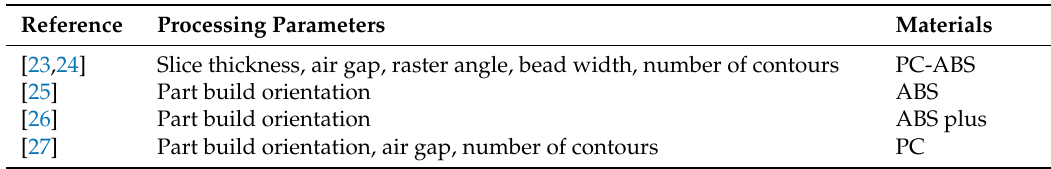
Table 1. Overview of previous creep and stress relaxation work in Fused-Deposition Modelling (FDM) technology by varying process